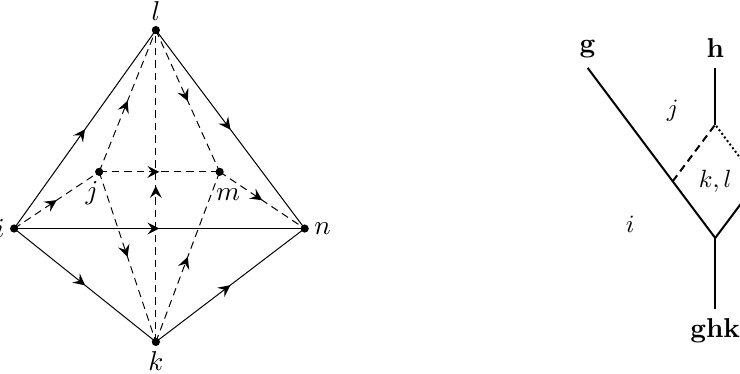
Figure 5 . Left: Minimal triangulation necessary to encode the con(cid:12)guration of codimension-1 symmetry defects in (cid:12)gure 4. The vertices f i; j; k; l; m; n g are ordered; in d dimensions the remaining d (cid:0) 3 dimensions are implicit. The con(cid:12)guration is made of an upper \pyramid" f ijlmn g and a lower upside-down pyramid f ijkmn g . Right: 2D section of the con(cid:12)guration of symmetry defects, seen from above. The nodes contained in each domain are indicated. The dashed line corresponds to the lower portion of (cid:12)gure 4 which contains the node k ; the dotted line corresponds to the upper portion of (cid:12)gure 4 which contains the node l . Therefore, the triangulation can encode a bordism between the two con(cid:12)gurations in (cid:12)gure